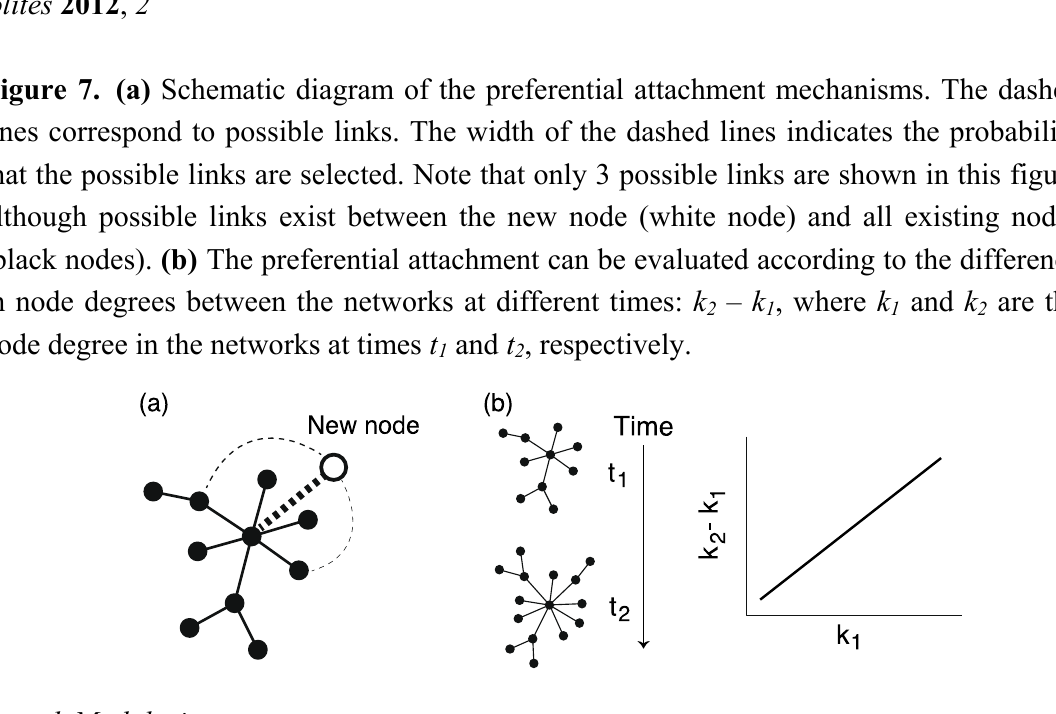
Figure 7. (a) Schematic diagram of the preferential attachment mechanisms. The dashed lines correspond to possible links. The width of the dashed lines indicates the probability that the possible links are selected. Note that only 3 possible links are shown in this figure although possible links exist between the new node (white node) and all existing nodes (black nodes). (b) The preferential attachment can be evaluated according to the difference in node degrees between the networks at different times: k node degree in the networks at times t